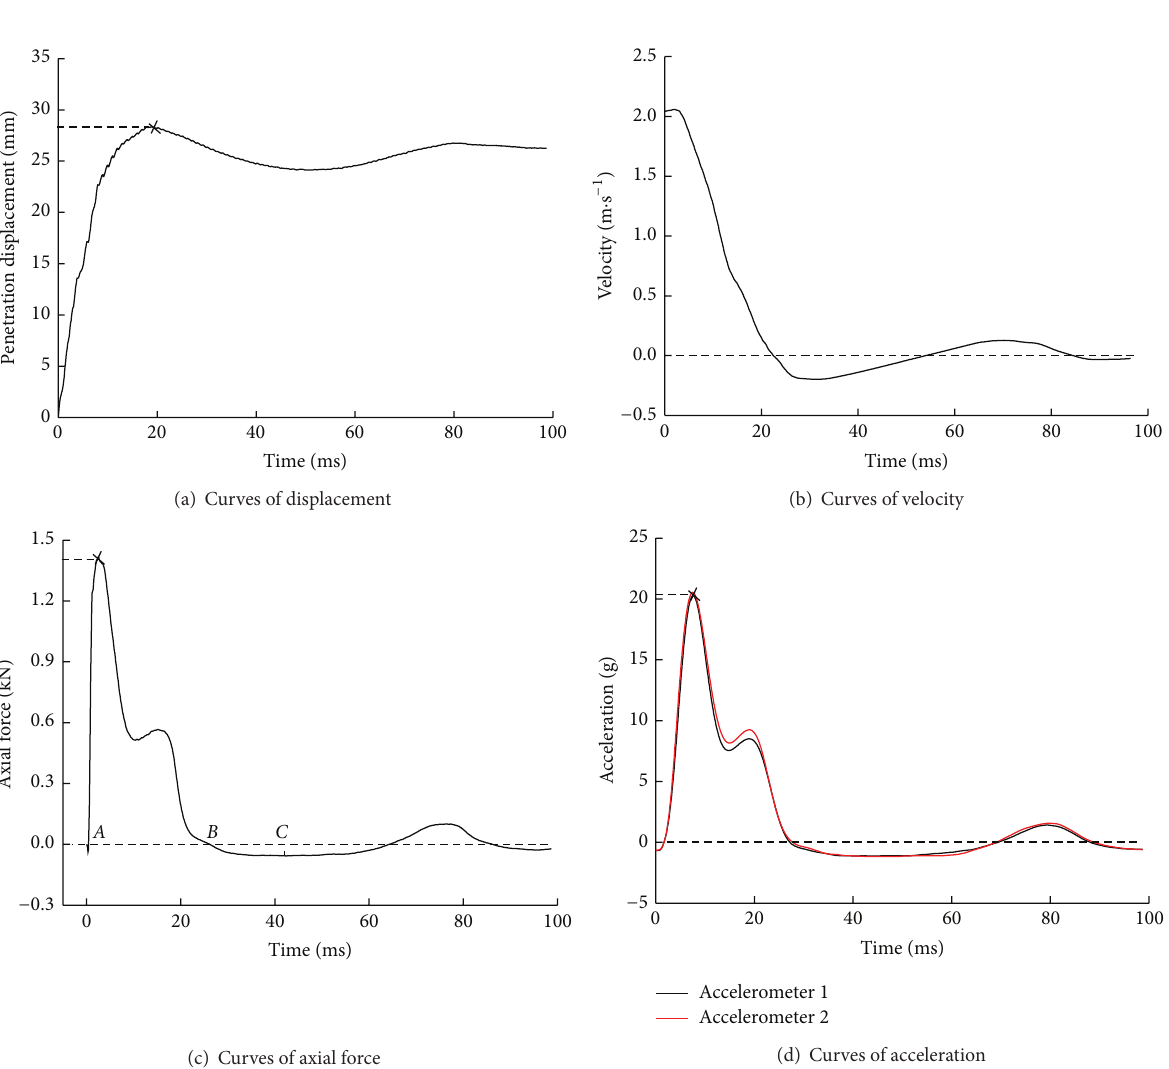
Figure 12: Time-history curves of contact-dynamic characteristics with 𝐷 𝑟 = 60 %, V = 2 m/s, and 𝑚 = 6